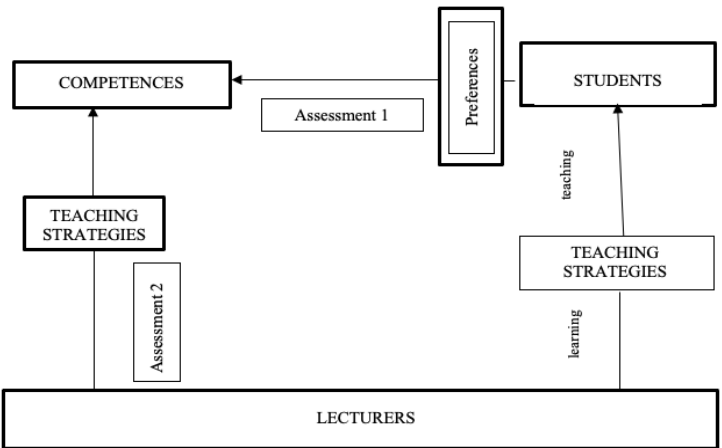
Figure 1. Description of the process.